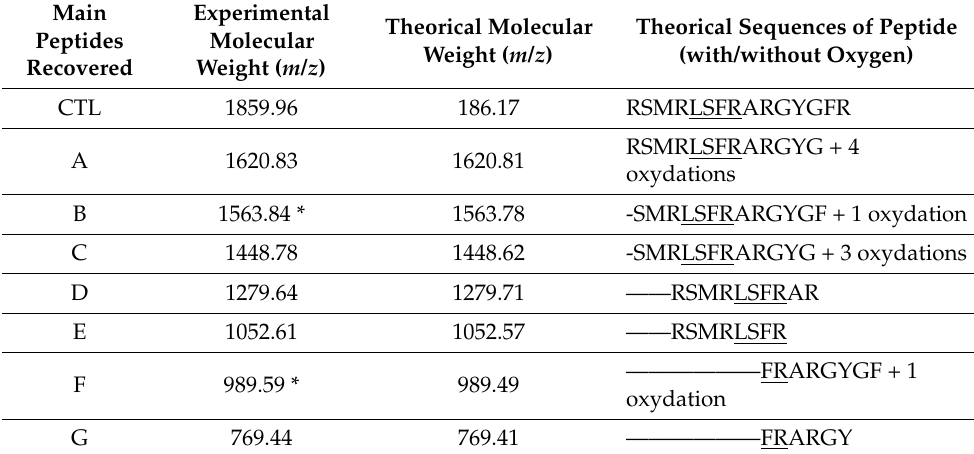
Table 1. Molecular weight as determined by MALDI-TOF mass spectrometry and sequence of the recovered peptides.